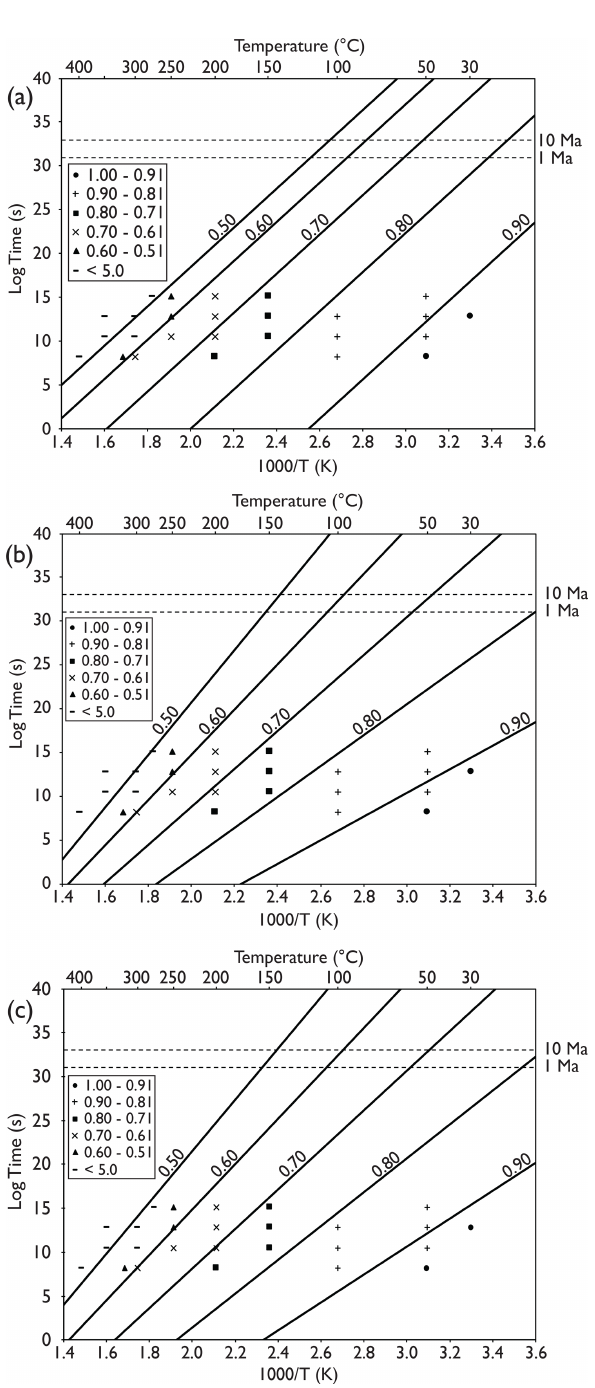
Figure 8. Arrhenius plots with fitted lines extrapolated to geologi- cal timescales: (a) parallel model, (b) fanning model ( T 0 (cid:54)= ∞ ) and (c) fanning model ( T 0 = ∞ ). Each plot was obtained by adopting specific equations, i.e., (a) Eq. (3), (b) Eq. (10) and (c) Eq. (11) (see text), and parameters as in Table 4. Values of normalized mean length ( r ) for each contour are indicated on the plots, ranging from 0.90 to 0.50. Symbols are the same as for Fig. 5.